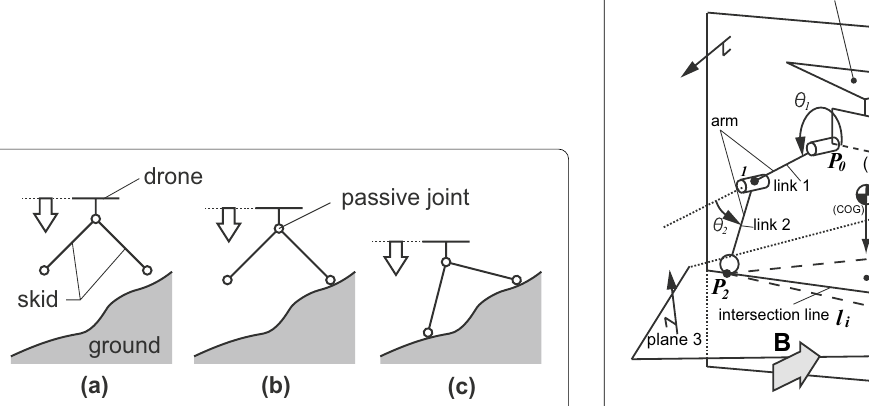
Fig. 5 Static model of the entire